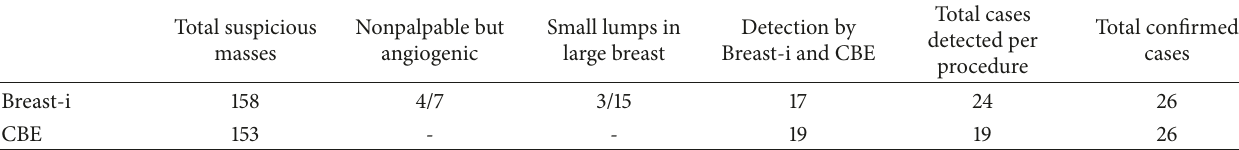
Table 3: Suspicious cases that were confirmed as